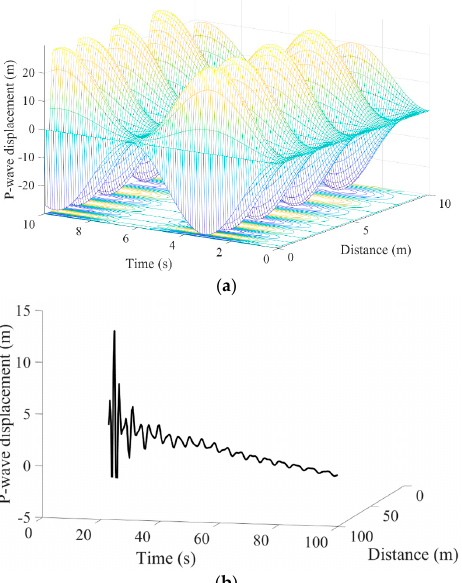
Figure 12. Change of P-wave displacement of the elastic wave with time and distance. ( a ) P-wave displacement over a short time and small scope. ( b ) P-wave displacement over a wide range and long period.